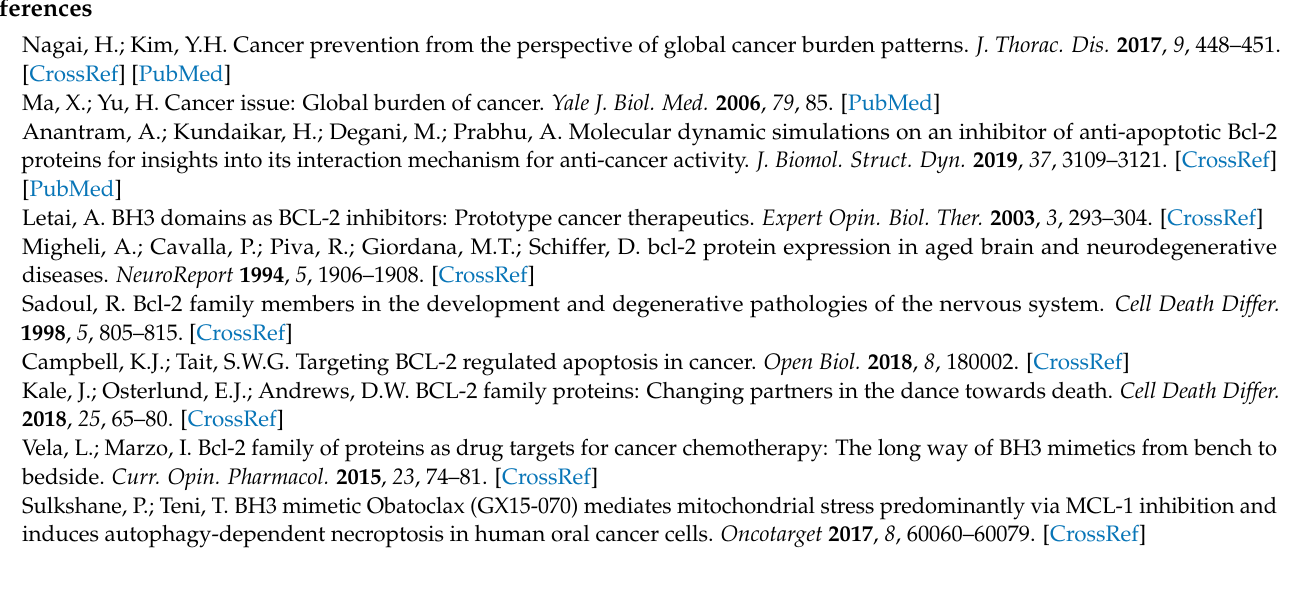
Table S1: Calculated fast and expensive docking scores (in kcal/mol) for venetoclax and the top 56 NPAtlas compounds against the Bcl-2 protein; Table S2: Estimated fast, expensive docking scores, and MM-GBSA binding energies (in kcal/mol) over 50 ns MD simulations for venetoclax and the top 42 NPAtlas compounds within the Bcl-2